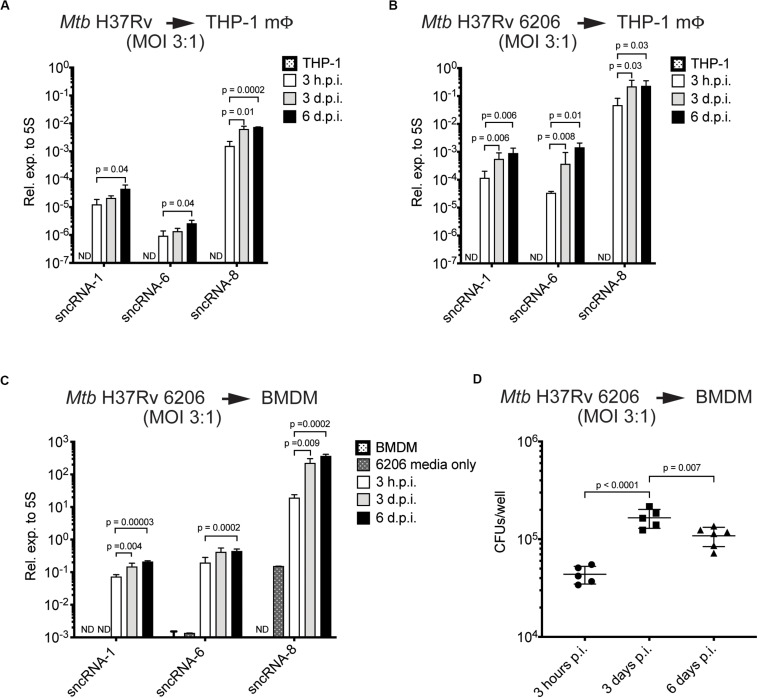
The levels of three distinct Mtb-encoded sncRNAs increase during the course of an infection. (A–C) Quantitative miRNA RT-PCR was performed on RNA extracted from THP-1 macrophages (A,B) or BMDMs (C) infected with Mtb H37Rv The Mtb strains included Mtb H37Rv (A) and an auxotroph mutant, Mtb H37Rv 6206 (ΔpanCD, ΔleuCD) (B,C). miRCURY locked nucleic acid (LNATM) modified primers selective for sncRNA-1, sncRNA-6, and sncRNA-8 were synthesized, along with a primer pair to detect mycobacterial 5S RNA, which was used for normalization purposes. The analysis was done with samples obtained 3 h, 3-days, and 6-days post-infection, using initial MOIs of 3:1. RNA was isolated from Mtb H37Rv 6206 incubated in the supplemented BMDM culture media for 3 h as a negative control in 6206 media only on panel (C). p-values were calculated using one-way ANOVA. p-values designated as significant (<0.05) are shown. ND designates not detected. Log scale was used to show the expression of three distinct sncRNAs. (D) CFU/well burden in infected BMDMs was determined 3- and 6-days post infection using initial MOIs of 3:1. Cells were lysed in 0.05% SDS and serially diluted before plating on supplemented 7H10 agar plates. Experiments in panels (C) and (D) were done in parallel. Shown are a representative image of two independent experiments.